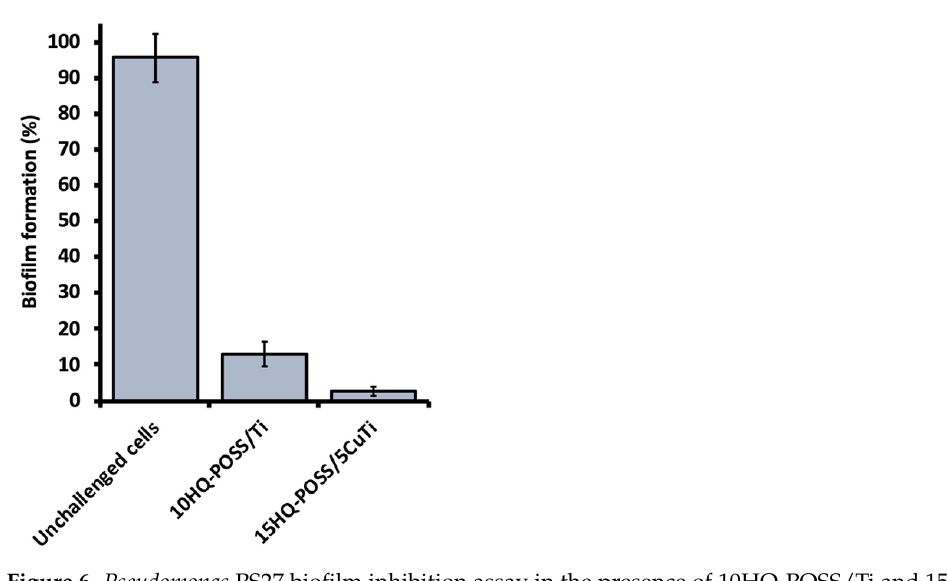
Figure 6. Pseudomonas PS27 biofilm inhibition assay in the presence of 10HQ-POSS/Ti and 15HQ- POSS/5CuTi formulations.